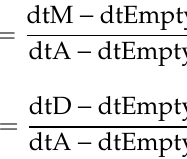
Table 7. Tests of scalar operation time cost with different hardware platforms. CPU, central processing unit; OS, operating system.